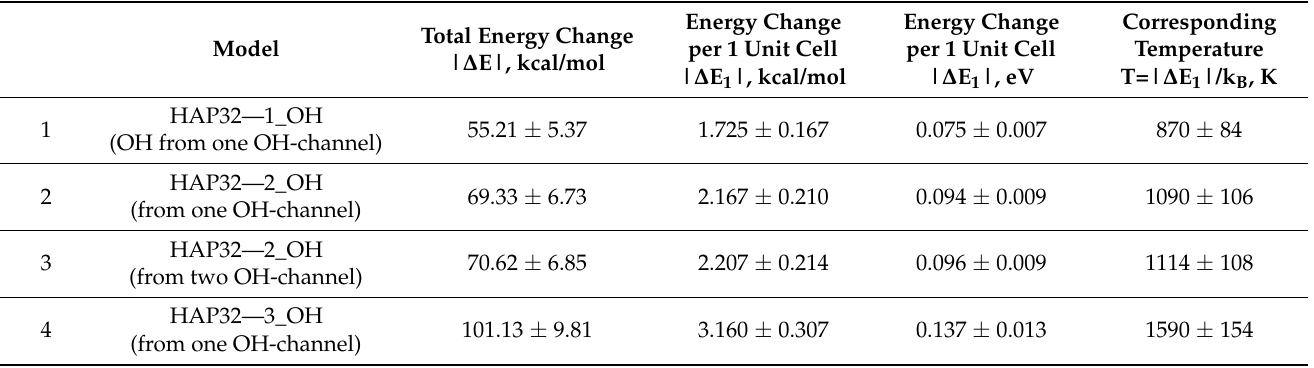
Table 1. Change in energy when extracting OH groups from a HAP32 cluster of 4 × 4 × 2 = 32 unit cells when they are removed to a large distance (more than 100